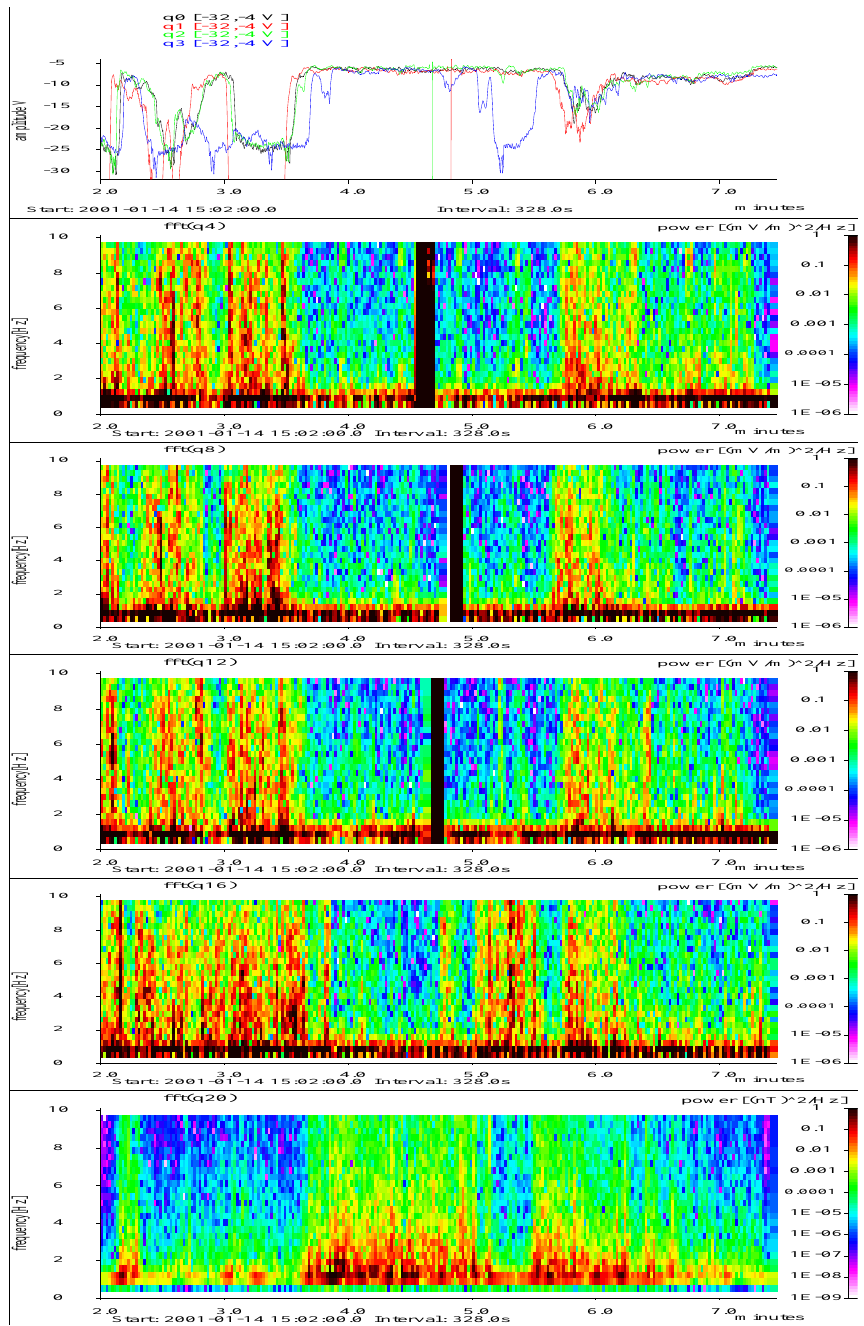
File: georg-efw.ps